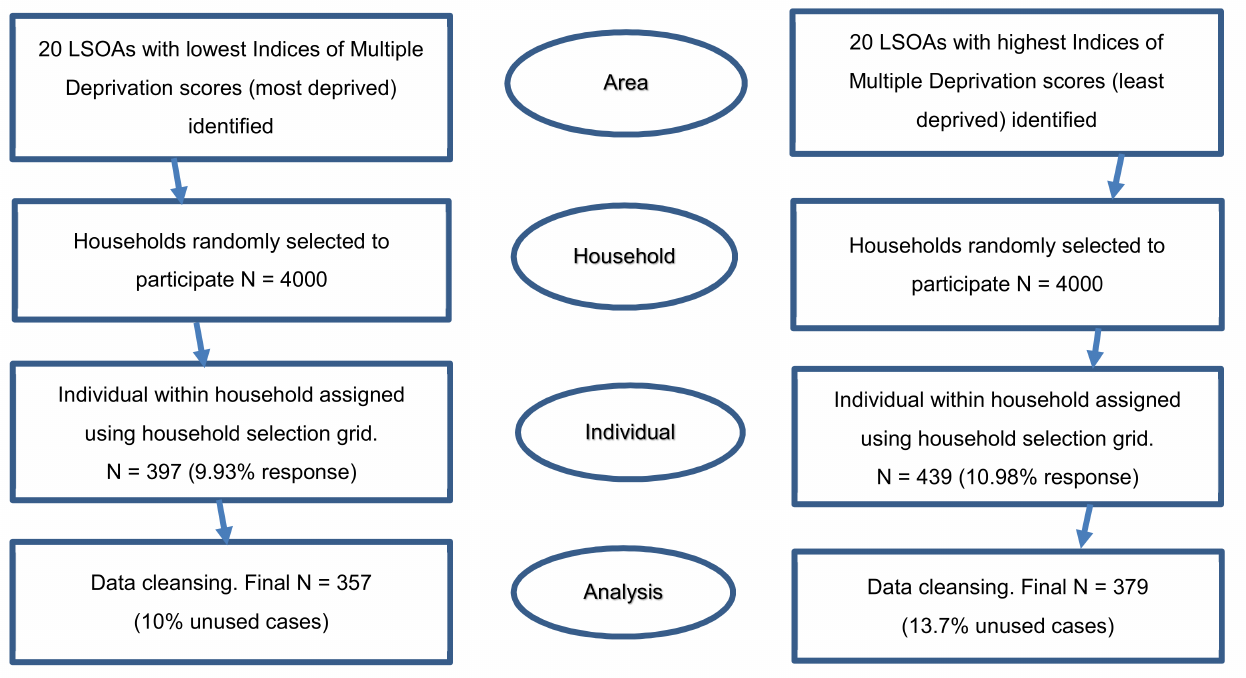
Figure 2. Sampling strategy for the survey